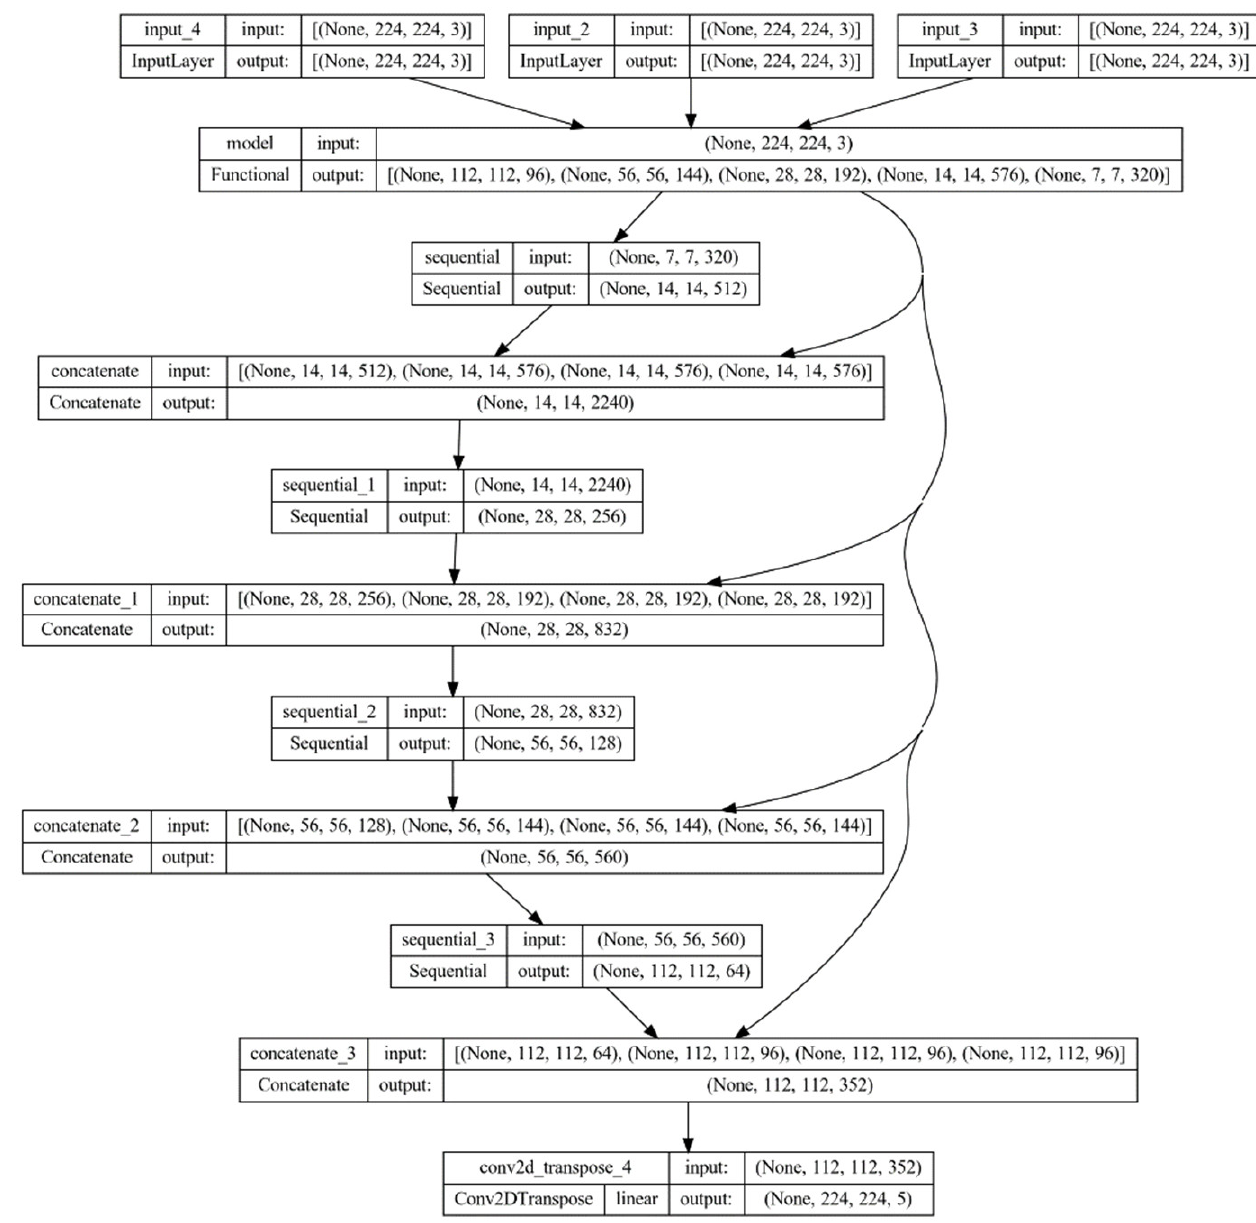
Figure A3. Segmentation model architecture with three data sources as input.